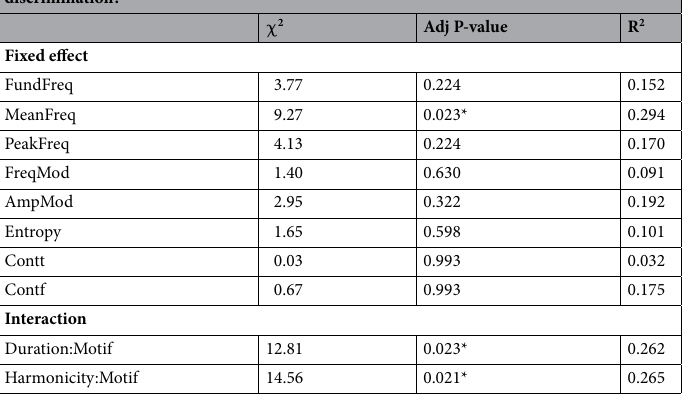
Table 1. Results of linear regression models asking what types of syllables were most easily discriminated. Each model consisted of mean PC* scores on each task other than the whole motif renditions (4 syllable rendition tasks for each of the 3 motifs) for each subject as the response variable (37 observations), the fixed effects were an acoustic feature of the relevant background syllable (e.g. duration), motif set (3 levels), and the interaction between motif set and acoustic feature, and the random effects were subject and task (12 levels) to account for the repeated measures design of the experiment. The formulas for the models were as